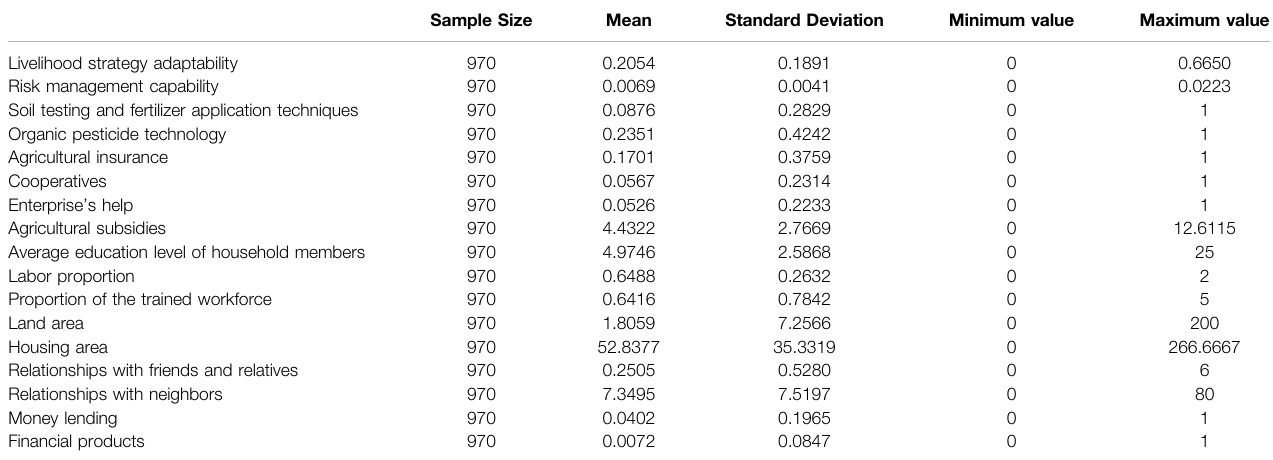
TABLE 3 | Descriptive statistics of